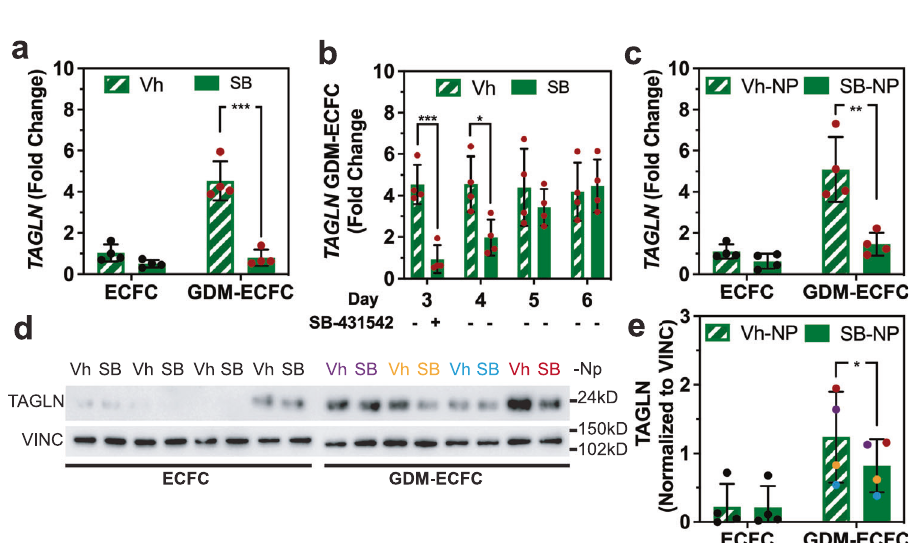
Fig. 3 Treatment with SB-431542 reduces TAGLN expression in GDM-ECFCs. a Real-time RT-PCR quanti fi cation of TAGLN expression in normal ECFC and GDM-ECFC under Vehicle (DMSO) control or treatment with 5 µ M SB-431542 (SB) for 72h (four biological replicates, n = 4; mean± s.d.). TAGLN expression is normalized to ECFC. b The inhibition effects of SB was transient, as the SB was removed from the medium at day 4, the TAGLN expression in GDM-ECFC at day 5 and 6 increased to level comparable to GDM-ECFC treated with vehicle control. c Real-time RT-PCR quanti fi cation of TAGLN expression in normal ECFC and GDM-ECFC conjugated with either Vh-NPs or SB-NPs after 6 days in culture (four biological replicates, n = 4; mean ±s.d.). Bioactive SB- NPs provided a continuous down regulation of TAGLN at the mRNA level following 6 days in culture. d Representative Western blot evaluating TAGLN is shown using whole cell lysates isolated at day 6 from normal ECFC ( n = 4) and GDM-ECFCs ( n = 4) conjugated with either Vh-NPs or SB-NPs. Vinculin (VINC) is the loading control. e Band intensities were quanti fi ed using Image J and TAGLN protein expression levels were normalized using VINC. Individual data sets are color-coded (purple, yellow, blue, and red) to match the corresponding western blot bands and the GDM severity in the patient population (Supplementary Table 1). Statistical signi fi cance was evaluated using Student ’ s t -test. Signi fi cance levels were set at * P < 0.05, ** P <0.01, *** P <